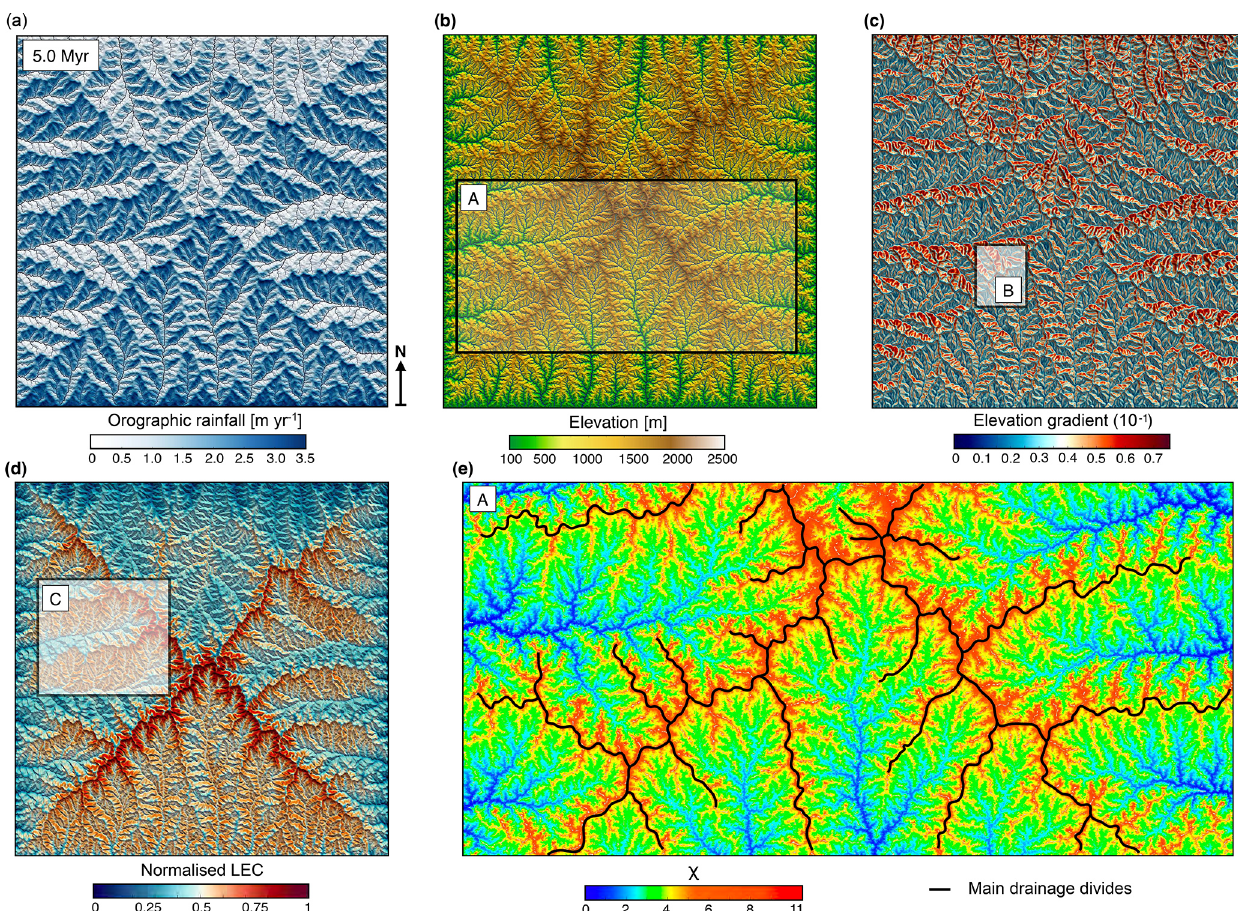
Figure 4. Generated outputs of the coupled landscape evolution and orographic precipitation models at the end of the uplift phase (5.0Myr). (a) Induced rainfall map from the orographic model in which precipitation is determined by prevailing upslope winds (coming from the south) and by the moisture content of the air. Rainfall distribution is characterised by precipitation maxima on the windward face of the divides. (b) Resulting elevation grid for which the topographic evolution of the mountain ranges is affected by the spatial pattern of precipitation and tectonics. During the building phase, main drainage divides continuously migrate towards the drier side and asymmetric topography develops with steeper regions (c) on the leeward side of the ranges. (d) Resulting normalised LEC showing specific patterns of distribution with higher values obtained on windward-facing catchments. At this time step, lower LECs are generally found in valleys and mountain tops, and higher LECs are found on the flanks of both the mountain tops and main valley systems. (e) χ map (Perron and Royden, 2013; Willett et al., 2014) for inset A (shown in panel b ) highlighting discontinuous χ across drainage divides, with larger χ values on the leeward-facing catchments ( victim basins) compared to the windward ones ( aggressor basins). Insets B and C refer to the region used in the analysis performed in Figs. 5 and 9,